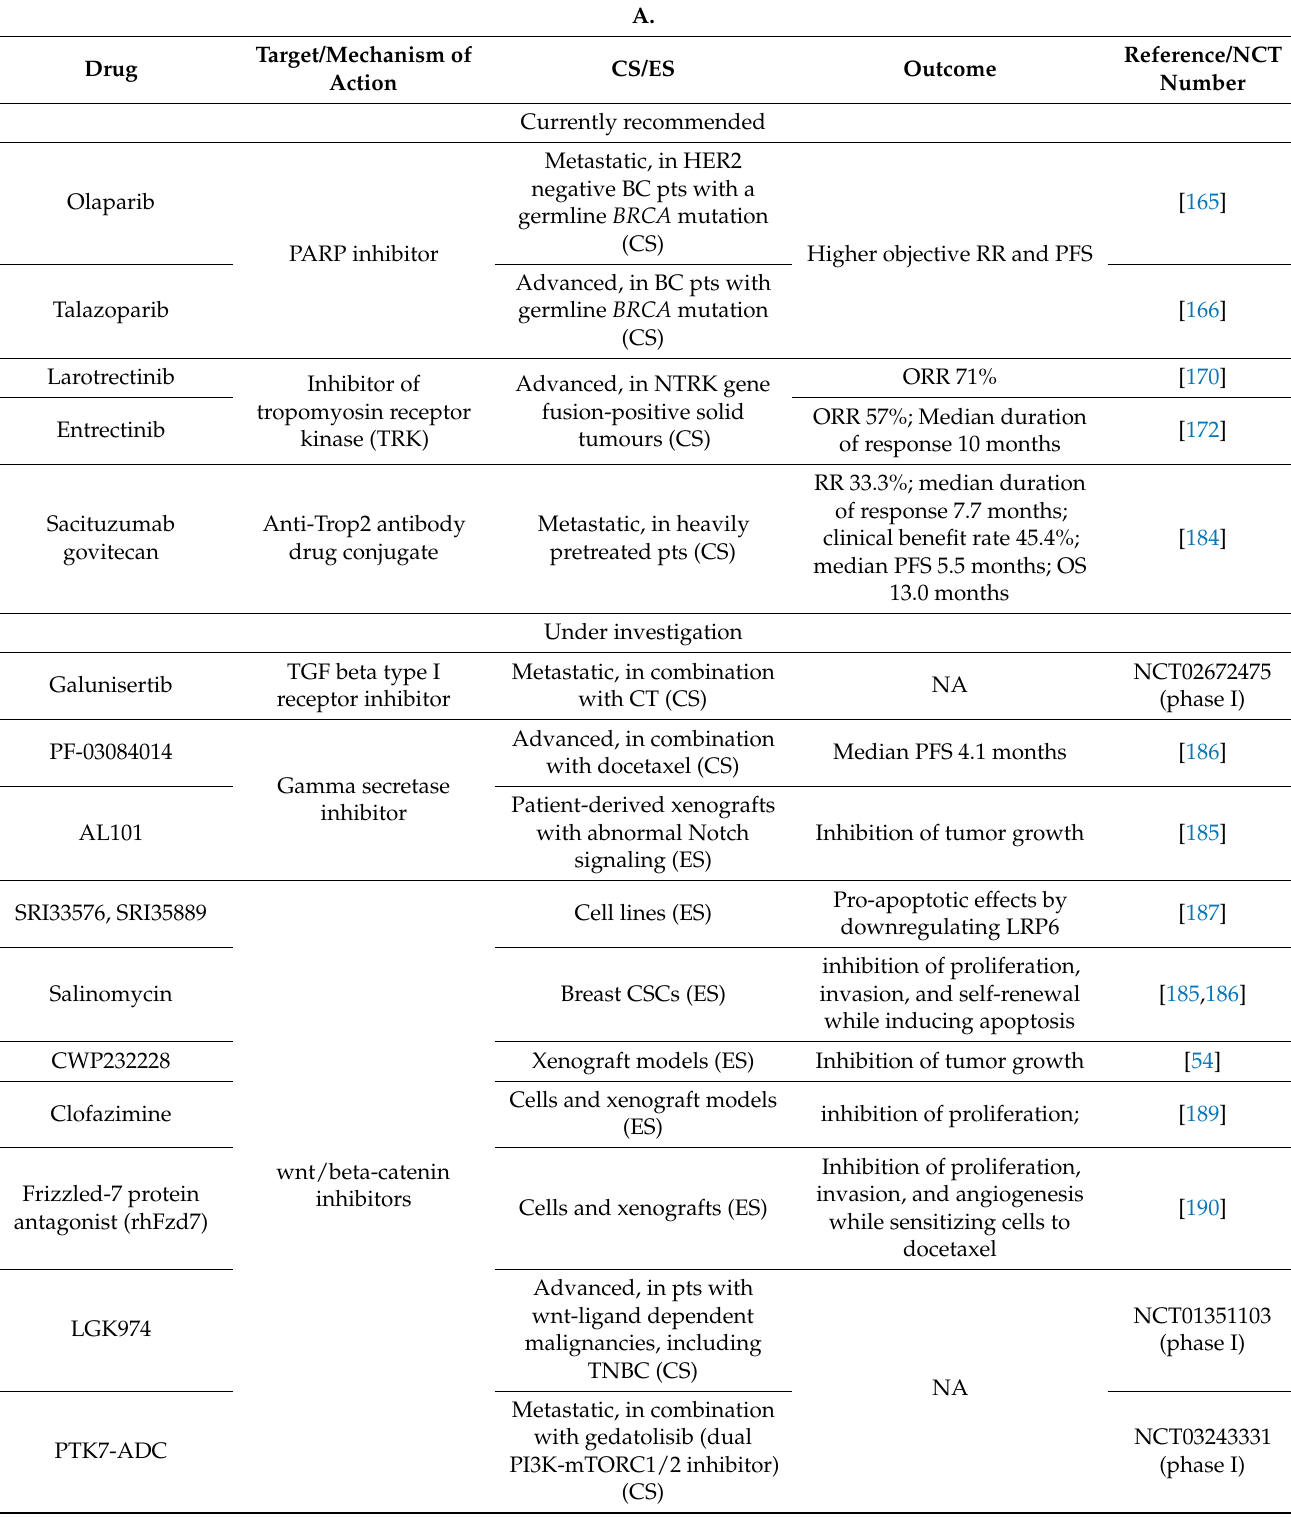
Table 3. Drugs currently recommended or potentially helpful in chemoresistant